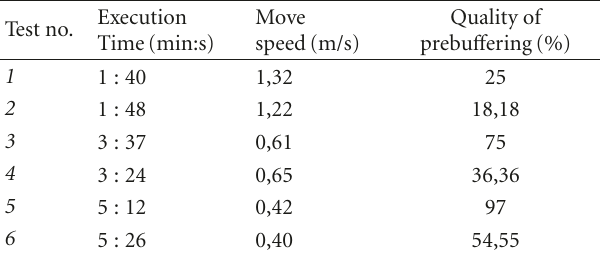
Table 6: PDPT Framework—Final Data transfer tests.